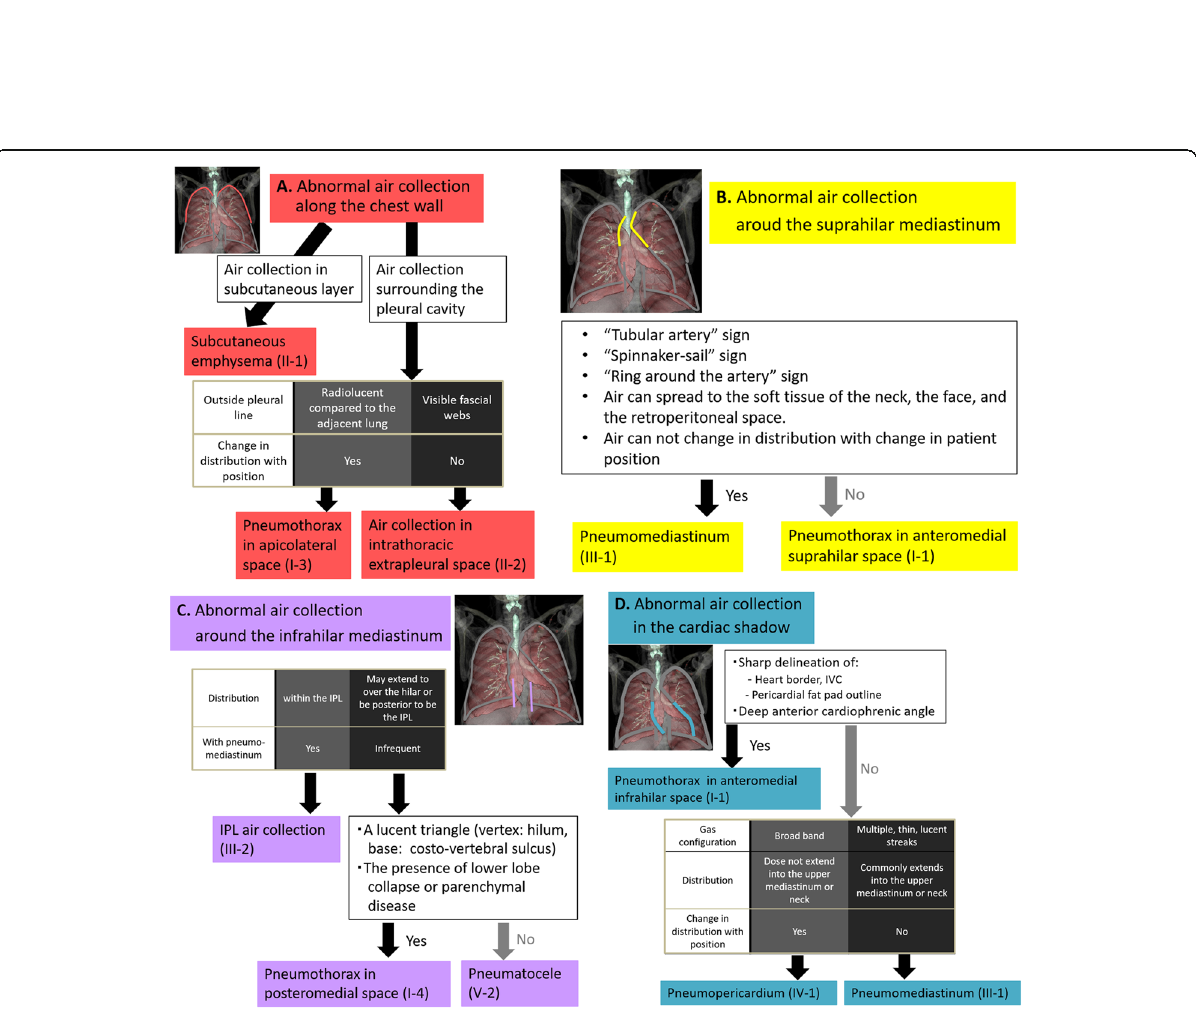
Fig. 22 Decision trees based on the location of air collection. a Abnormal air collection along the chest wall. b Abnormal air collection around the suprahilar mediastinum. c Abnormal air collection around the infrahilar mediastinum. d Abnormal air collection in the cardiac shadow